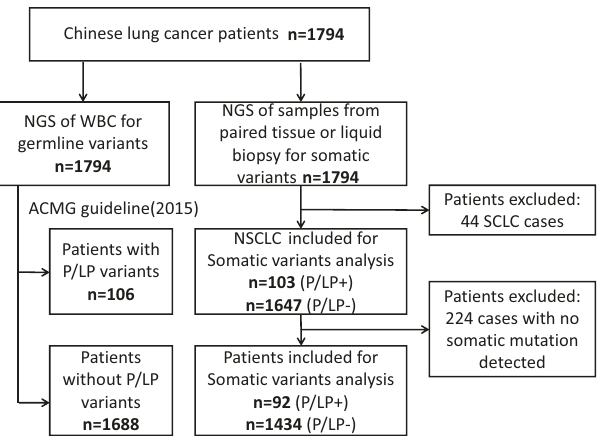
Fig. 1 Study scheme of patient cohort. Patients diagnosed with lung caner went through targeted sequencing as part of clinical care from November 2017 to August 2018 were included for further analysis. NGS